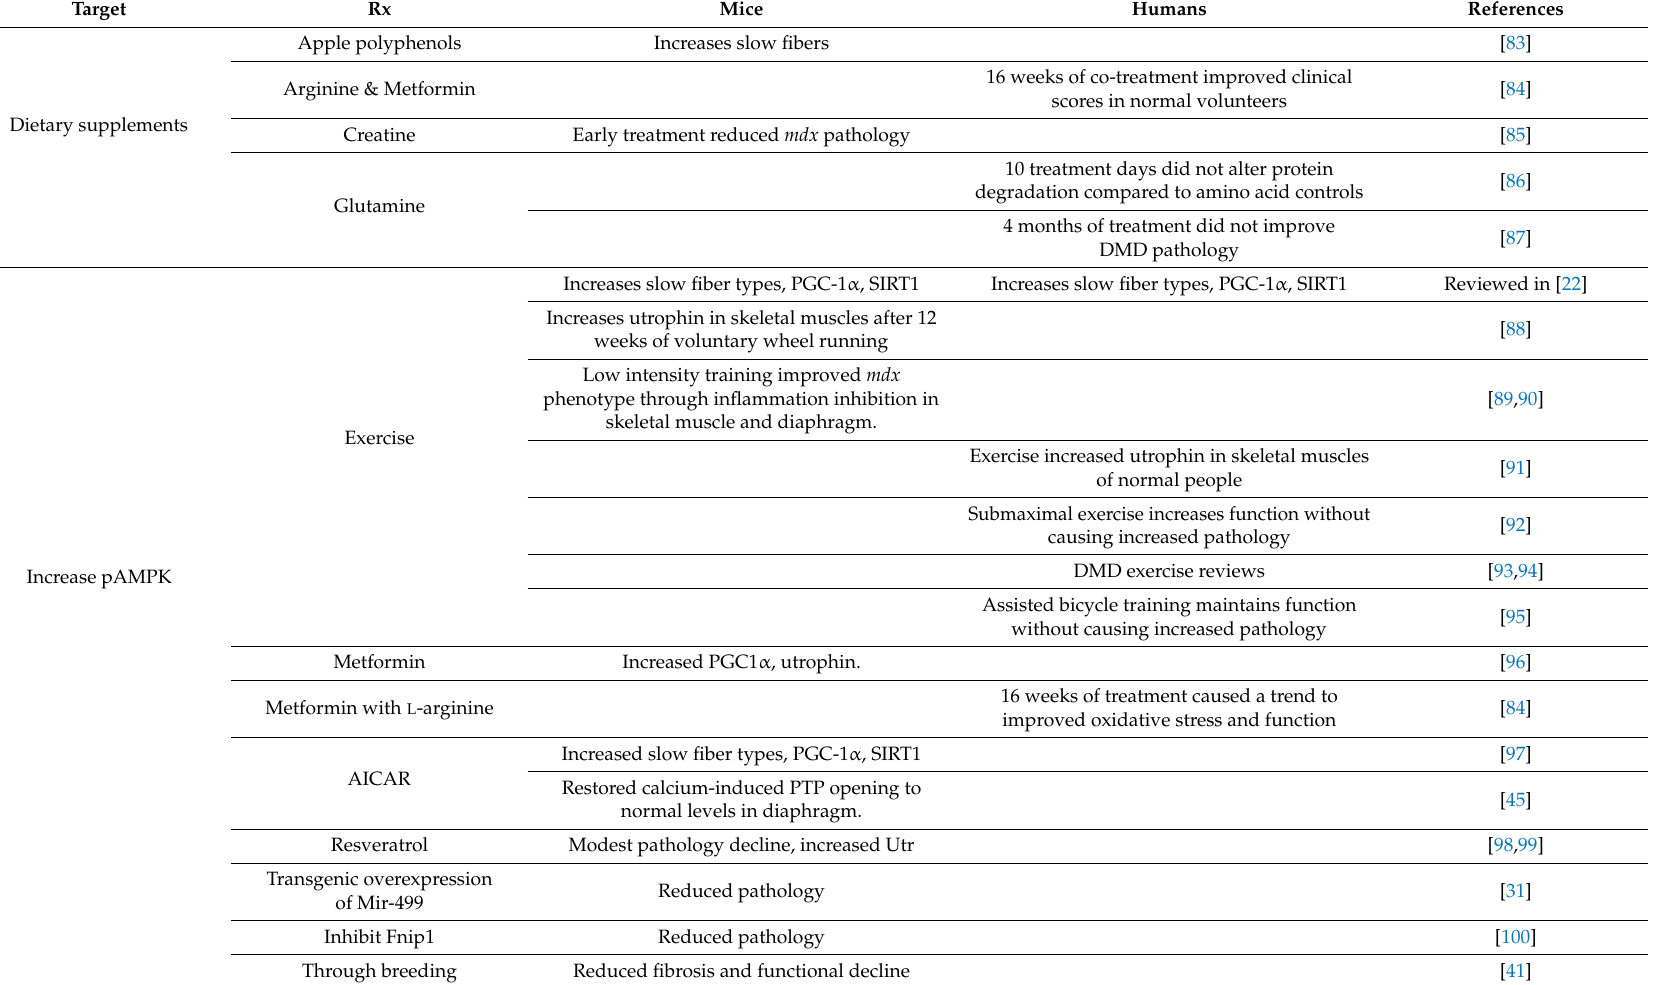
Table 1. Metabolic targets to treat muscular